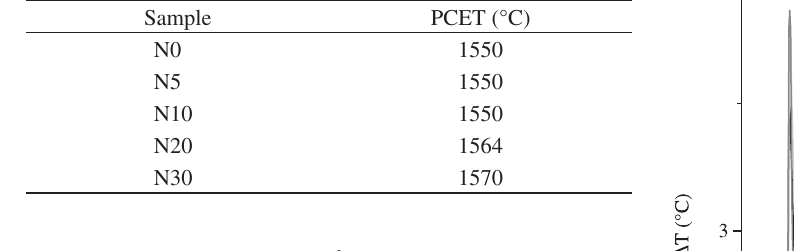
Table 6. Blaine specific surface, Se (m 2 /Kg). Sample